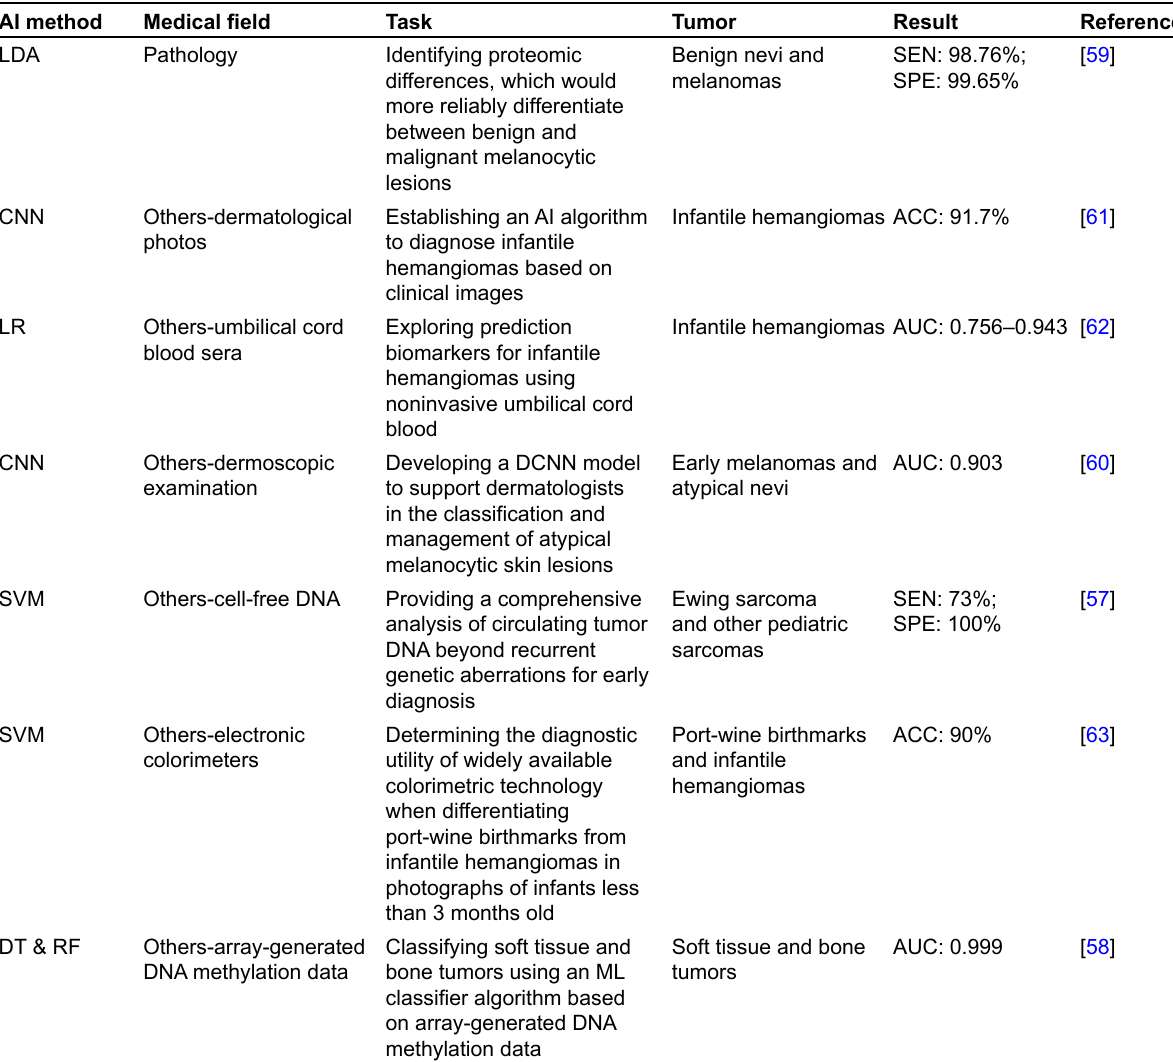
Table 3. Current AI applications in the diagnosis of childhood extracranial tumor ( continued ) AI